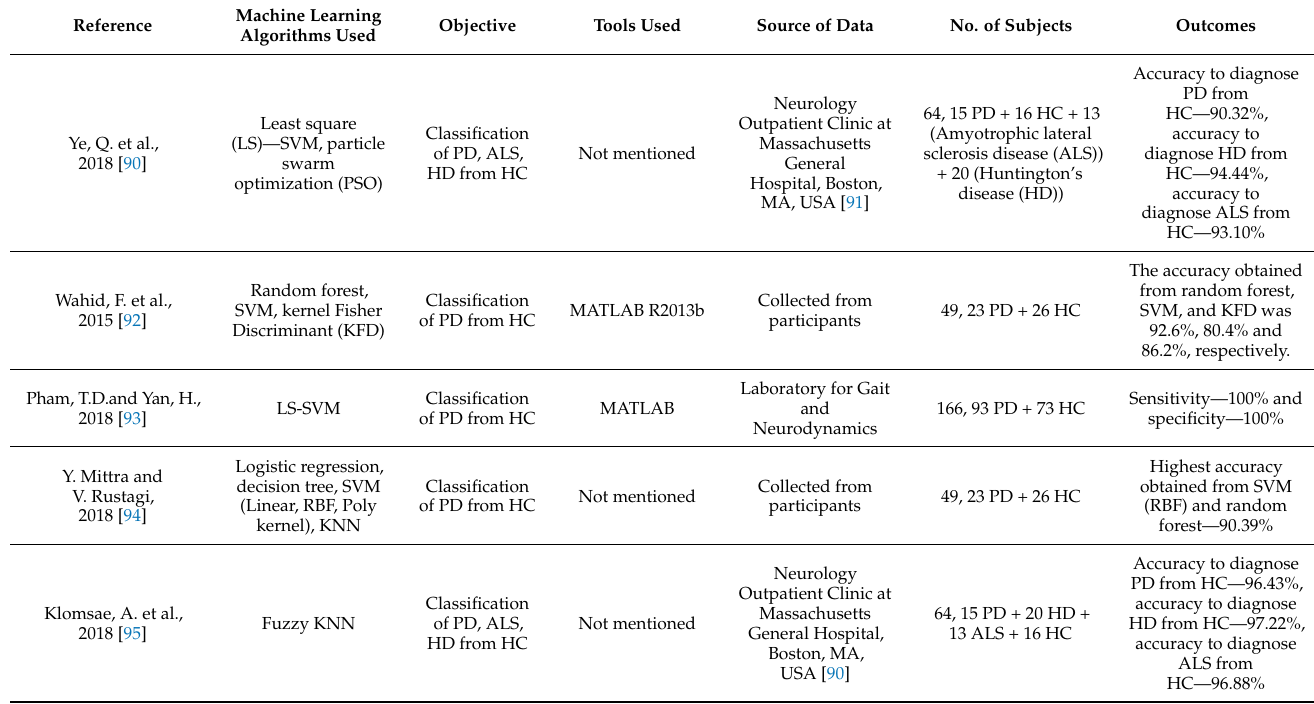
Table 3. Comparative studies of machine learning approaches in gait dataset to diagnose